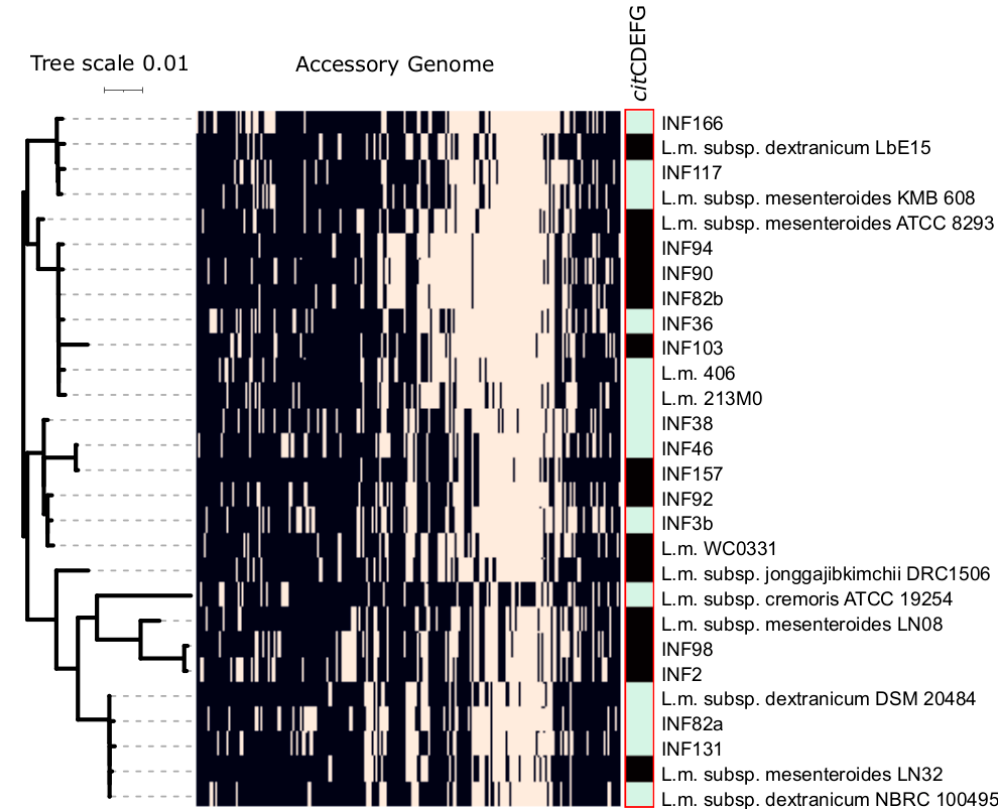
Figure 3. Schematic presentation of present (light colors) and absent (black) orthologous groups as determined by Or- thofinder analysis and the cit operon (green) in Montenegrin brine cheese isolates. Table 3. AMR targets, virulence genes, plasmids, pathogenicity, (S) susceptible, (Ery) erythromycin, (Amp) ampicillin, (Pen) penicillin, (Inhz) inhibition zone, (-) negative, and (nd) not done.